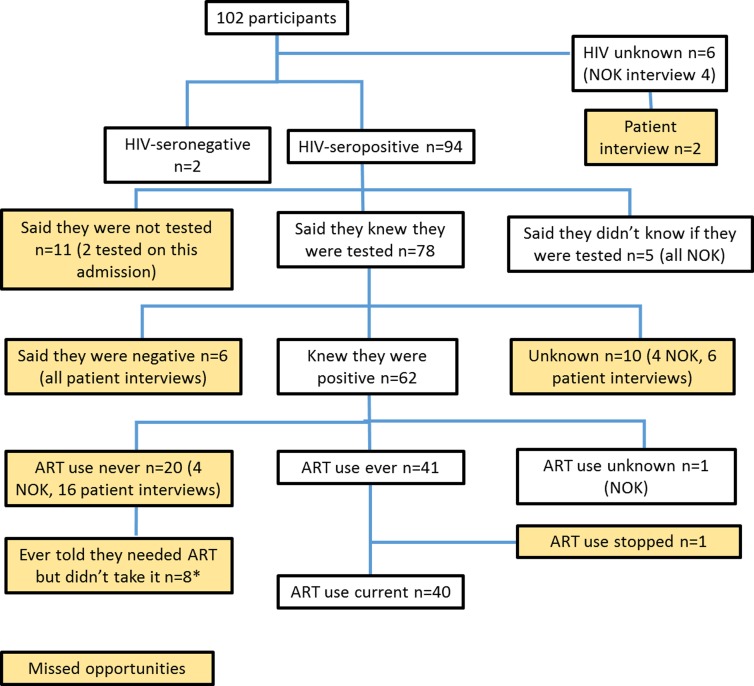
HIV testing, antiretroviral treatment and missed opportunities.Legend: NOK = next of kin, *Reasons for not starting ART: afraid of side effects (n = 2), no food (n = 1), dropped out/ did not complete adherence counselling (n = 3), relocated (n = 1), on some treatment (n = 1).